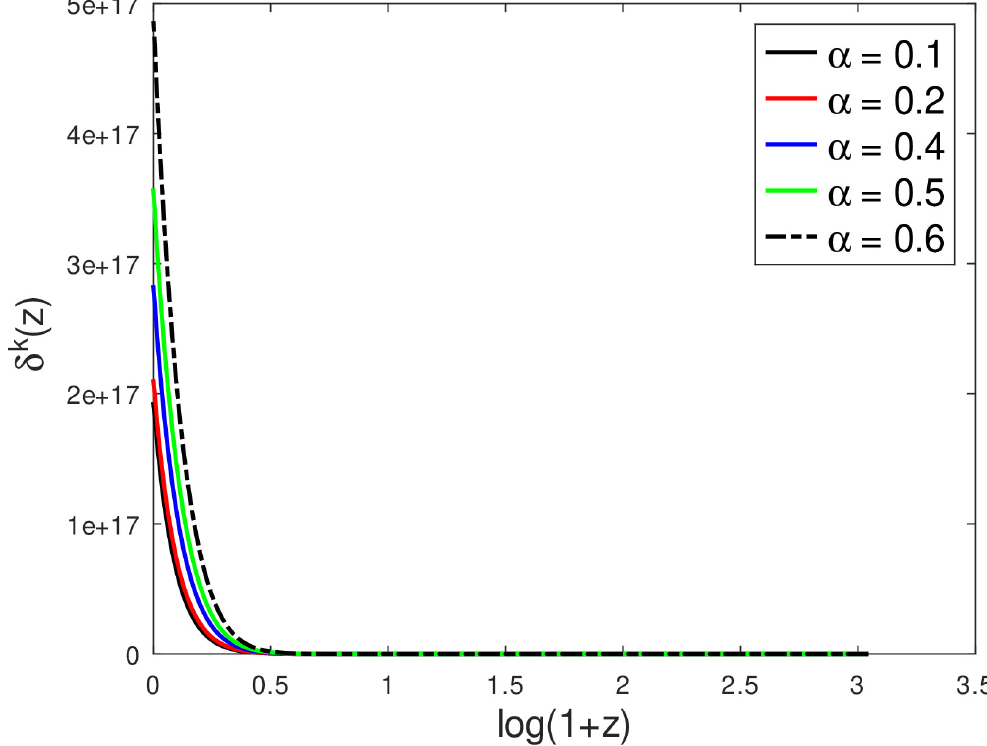
Figure 9. The variation of the matter density perturbations δ k ( z ) for a viscous Bianchi type-V cosmological model vs. redshift for γ = 4, β = 1, n = 0.2, and different values of α